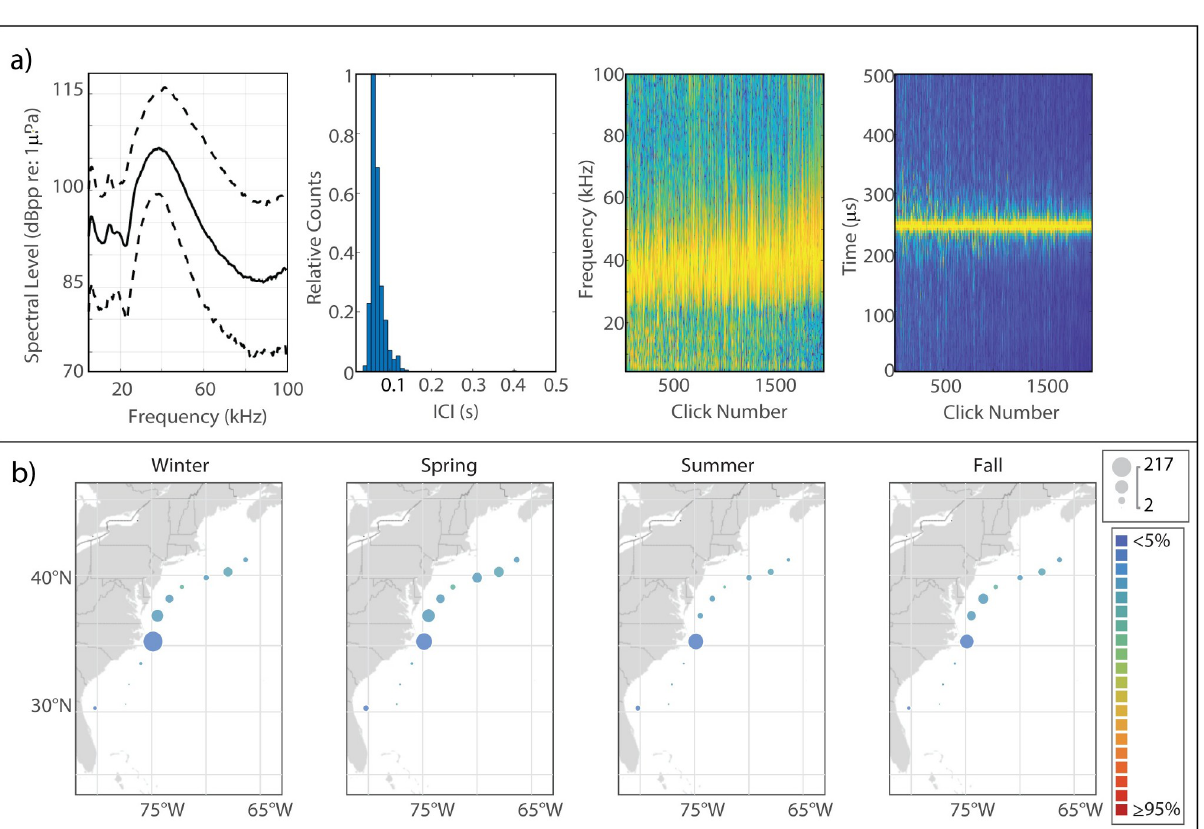
Fig 16. Results for UD38 showing click type (a), and acoustic presence (b). Subplots as in Fig 2a and